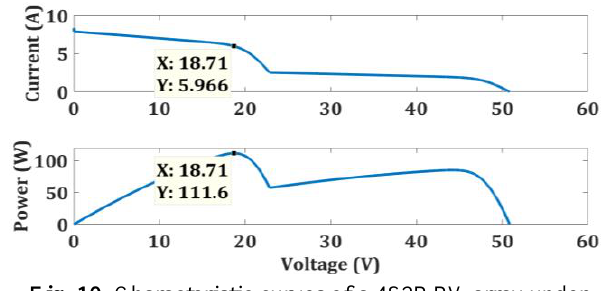
Fig. 10. Characteristic curves of a 4S2P PV array under weak PSC